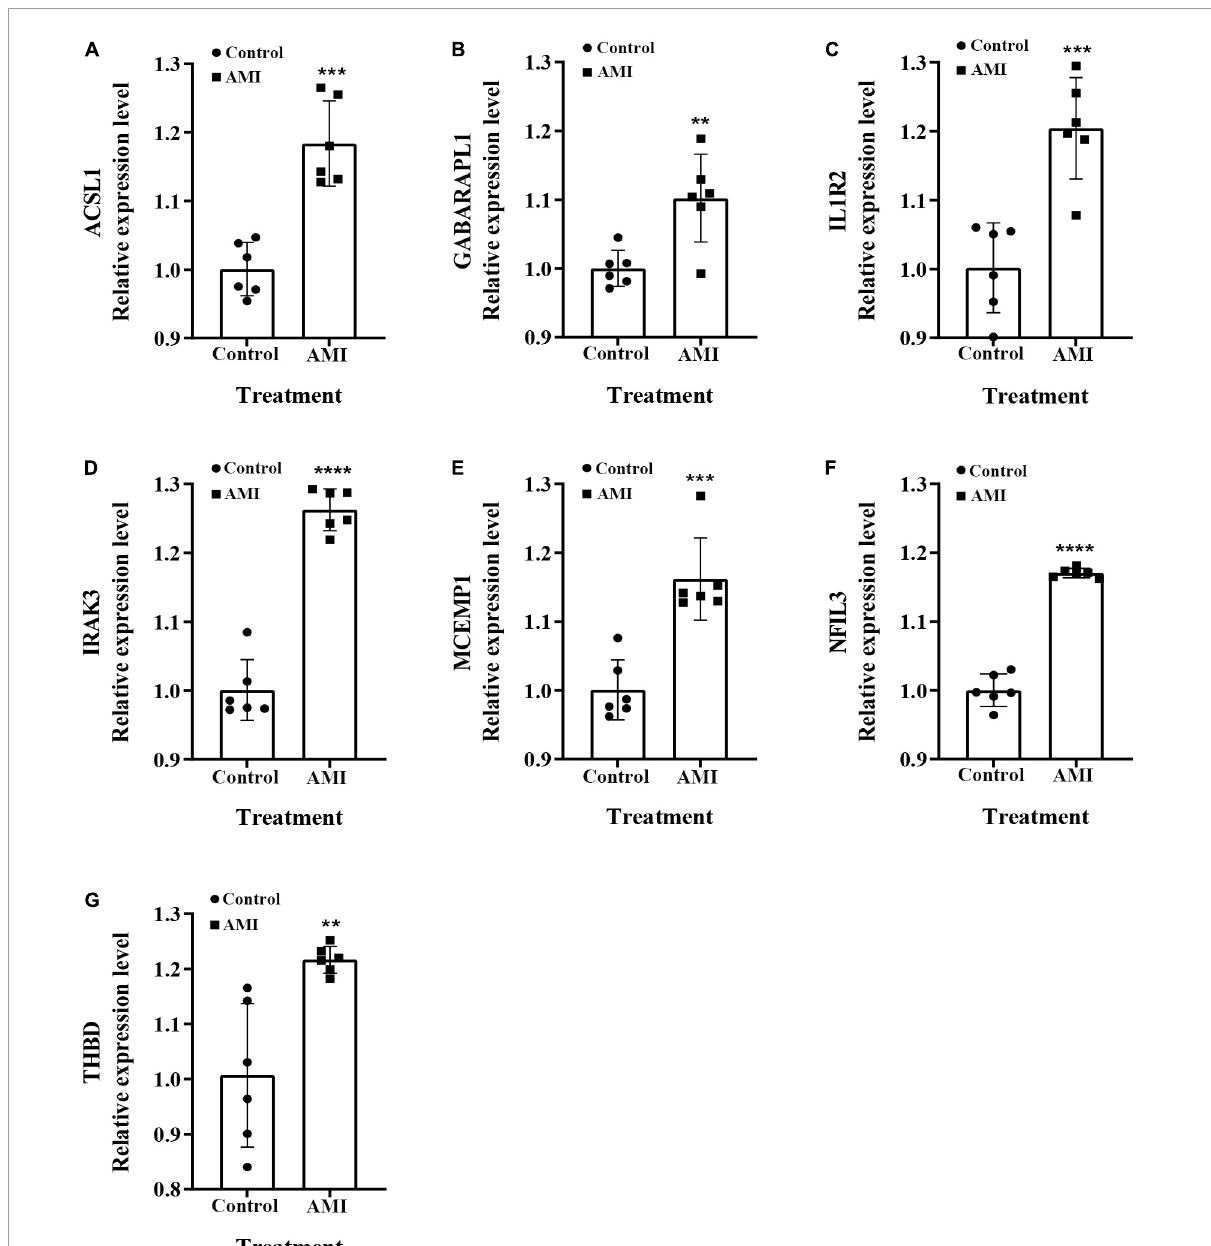
FIGURE11 The relative expressions of optimal feature genes were validated by qRT-PCR. (A–G) The expressions of ACSL1 (A) , GABARAPL1 (B) , IL1R2 (C) , IRAK3 (D) , MCEMP1 (E) , NFIL3 (F) , and THBD (G) between AMI patients and healthy subjects. Statistic tests: Student’s t -test ( P < 0.01**; P < 0.001***; P <